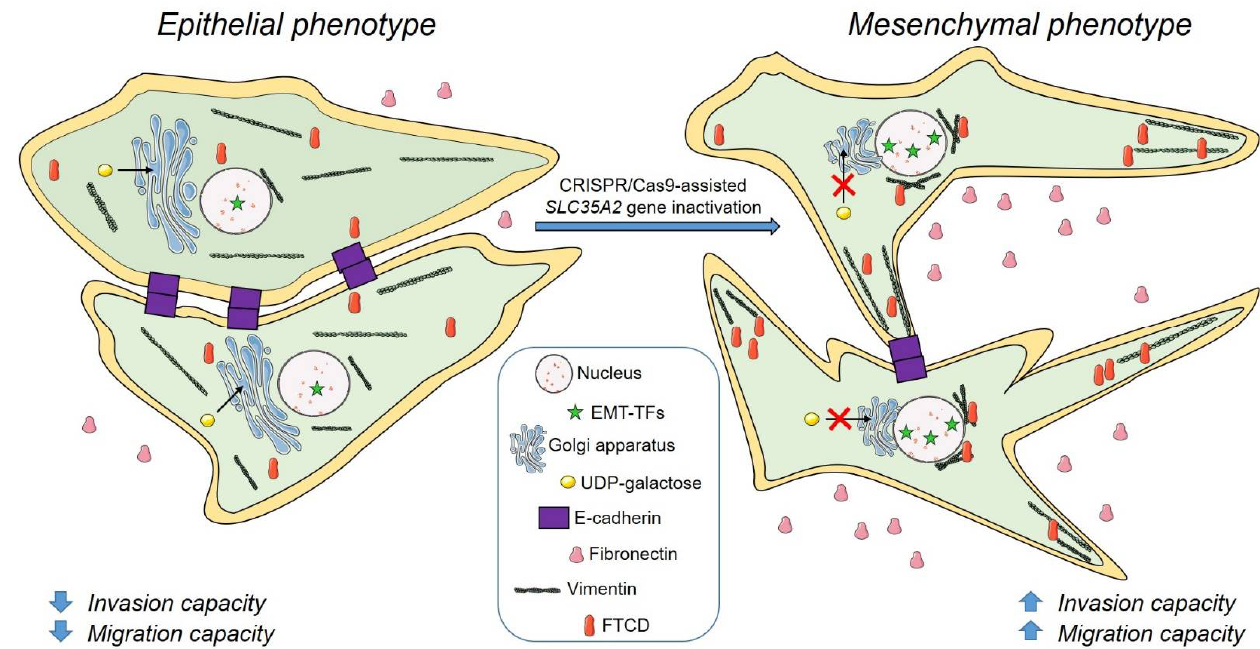
Figure 9. A summary of EMT-related changes in MDCK cells occurring upon the SLC35A2 gene knockout. MDCK cells deficient in the SLC35A2 activity display increased levels of selected EMT-activating transcription factors (EMT-TFs), i.e., ZEB1/Slug, downregulation of E-cadherin